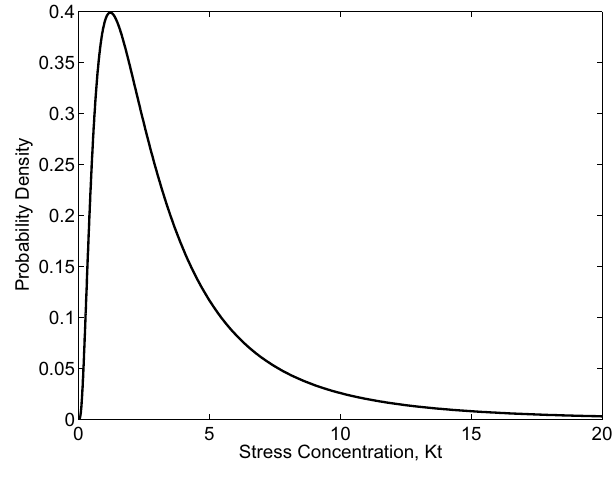
Fig. 8. Foreign object damage